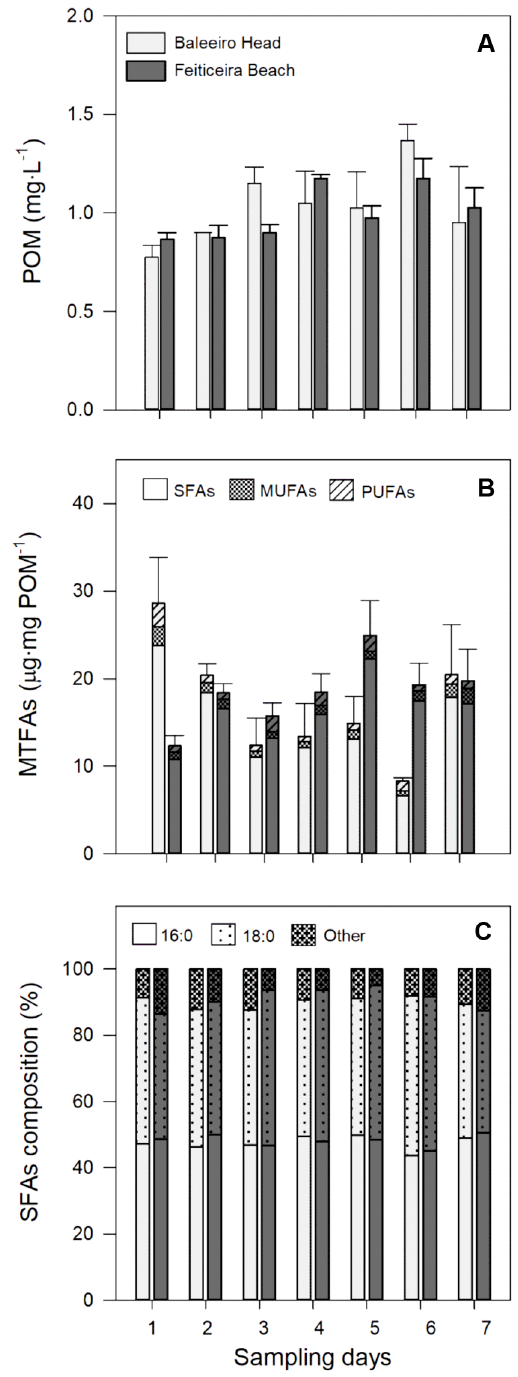
Fig. 1. Trophic conditions in the São Sebastião Channel throughout the sampling period. A) Particulate organic matter (POM); B) Mass of total fatty acids (MTFA); C) Composition of seston's saturated fatty acids (SFA). Values shown are averages and error bars are ( F 1.11; p = 0.332), with similar variation at both sites across site= time(Fig.1A),assuggestedbythelackofinteractivesite vs .date 1.00, p = 0.445) in spite of signi fi cant overall effects ( F dayXsite= 4.50, p = 0.045). However, the trophic temporal variation ( F day= quality of the organic inputs (as MTFAs) was markedly